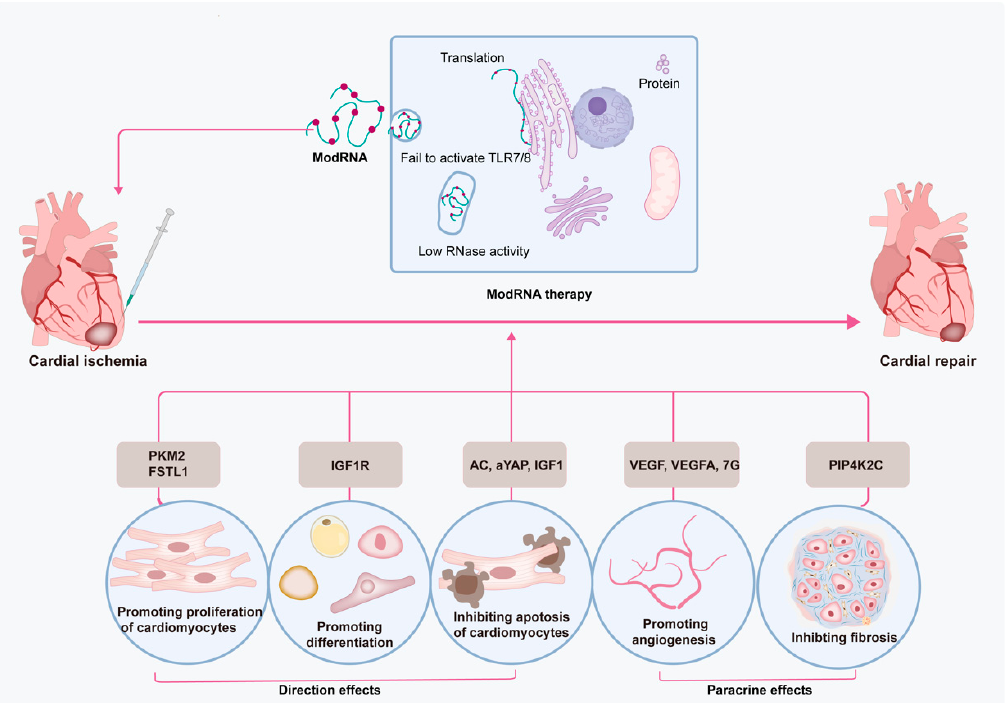
Figure 2. The mechanisms of modRNA-based therapy in MI treatment. modRNA-based therapy not only directly protects CMs but also through the paracrine effect alleviates the harsh microenvironment of the myocardium, for example, inhibiting fibrosis and promoting angiogenesis. Therein, VEGF and VEGF-A both have important effects on angiogenesis and pro-angiogenic differentiation in modRNA-based therapy. FSTL1 and PKM2 modRNA promote CM proliferation, and IGF-1R modRNA promotes differentiation of EPDCs. AC, aYAP, and IGF1 modRNA inhibit apoptosis of CMs. PIP4K2C modRNA inhibits MI fibrosis.